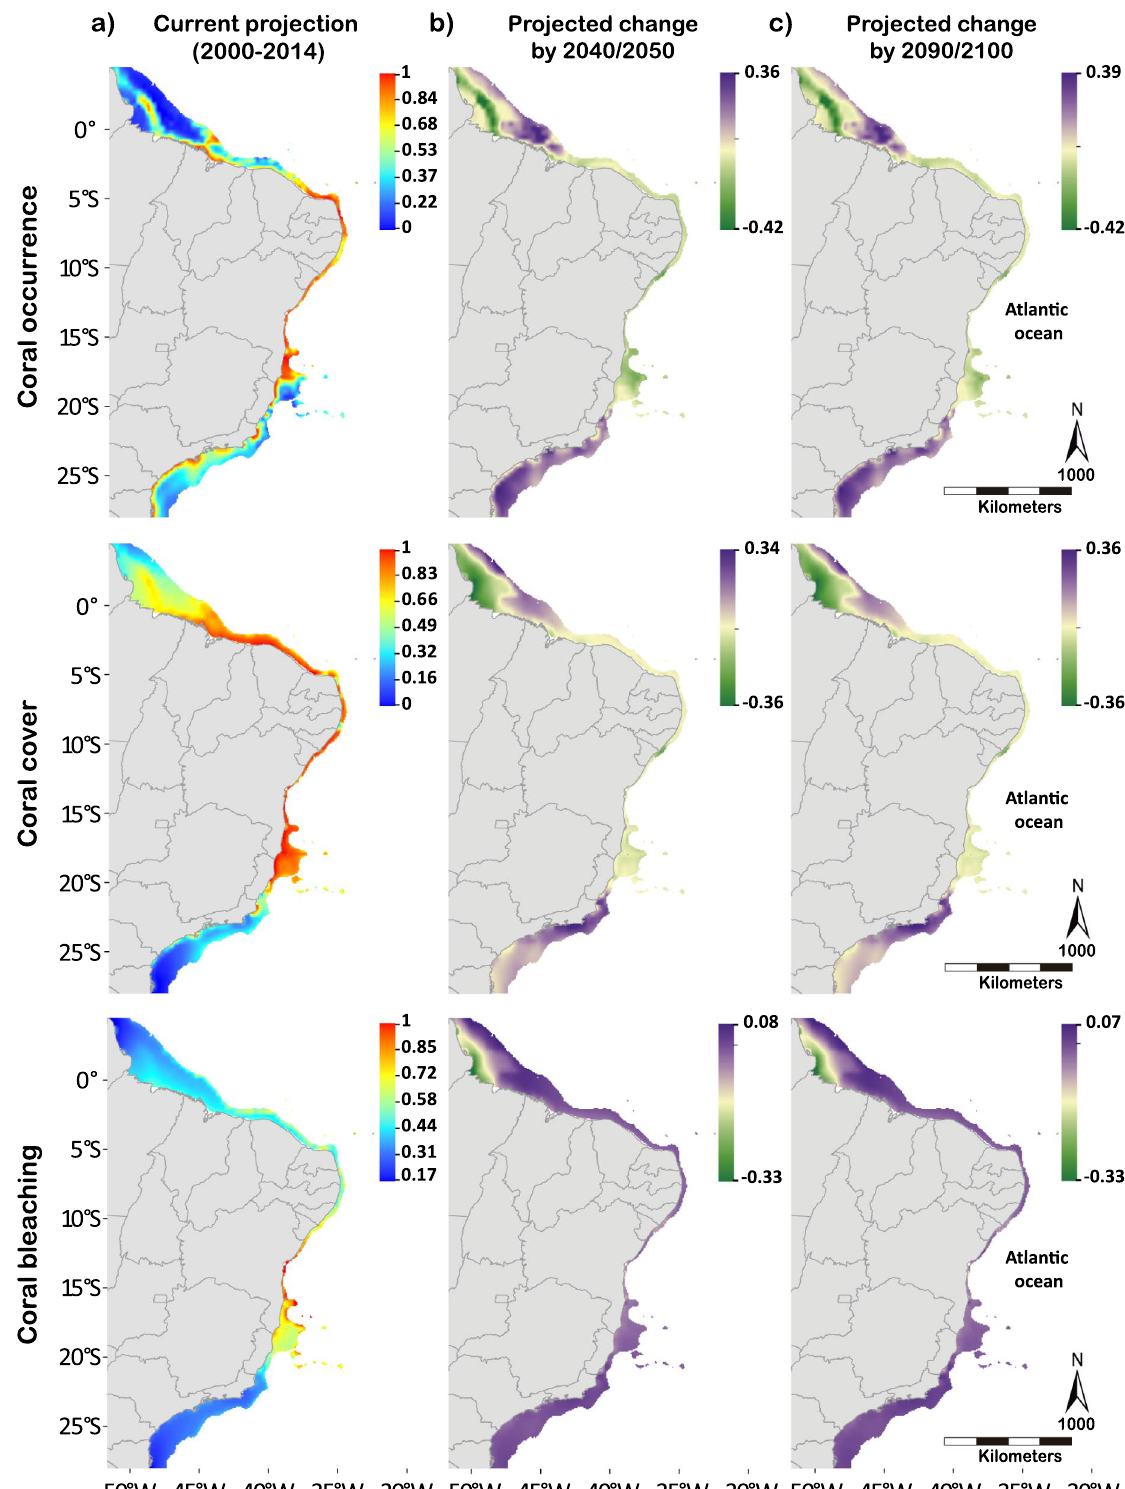
Figure 1. Probability maps for current projections and delta maps of projected changes between current and future scenarios of coral occurrence, coral cover and coral bleaching along the Southwestern Atlantic coastline (1°N–27°S latitude). ( a ) The probability maps for coral occurrence, cover, and bleaching for the current scenario (2000–2014) and ( b , c ) delta maps between current and the future scenarios (2040–2050 minus 2000–2014, left; and 2090–2100 minus 2000–2014, right) under a “business as usual” warming rate (RCP 8.5). The blue-red and green-purple scale bars represent absolute probability values and delta probability values, respectively. Maps created in ArcMap version 10.2 (https:// deskt op. arcgis. com/ en/